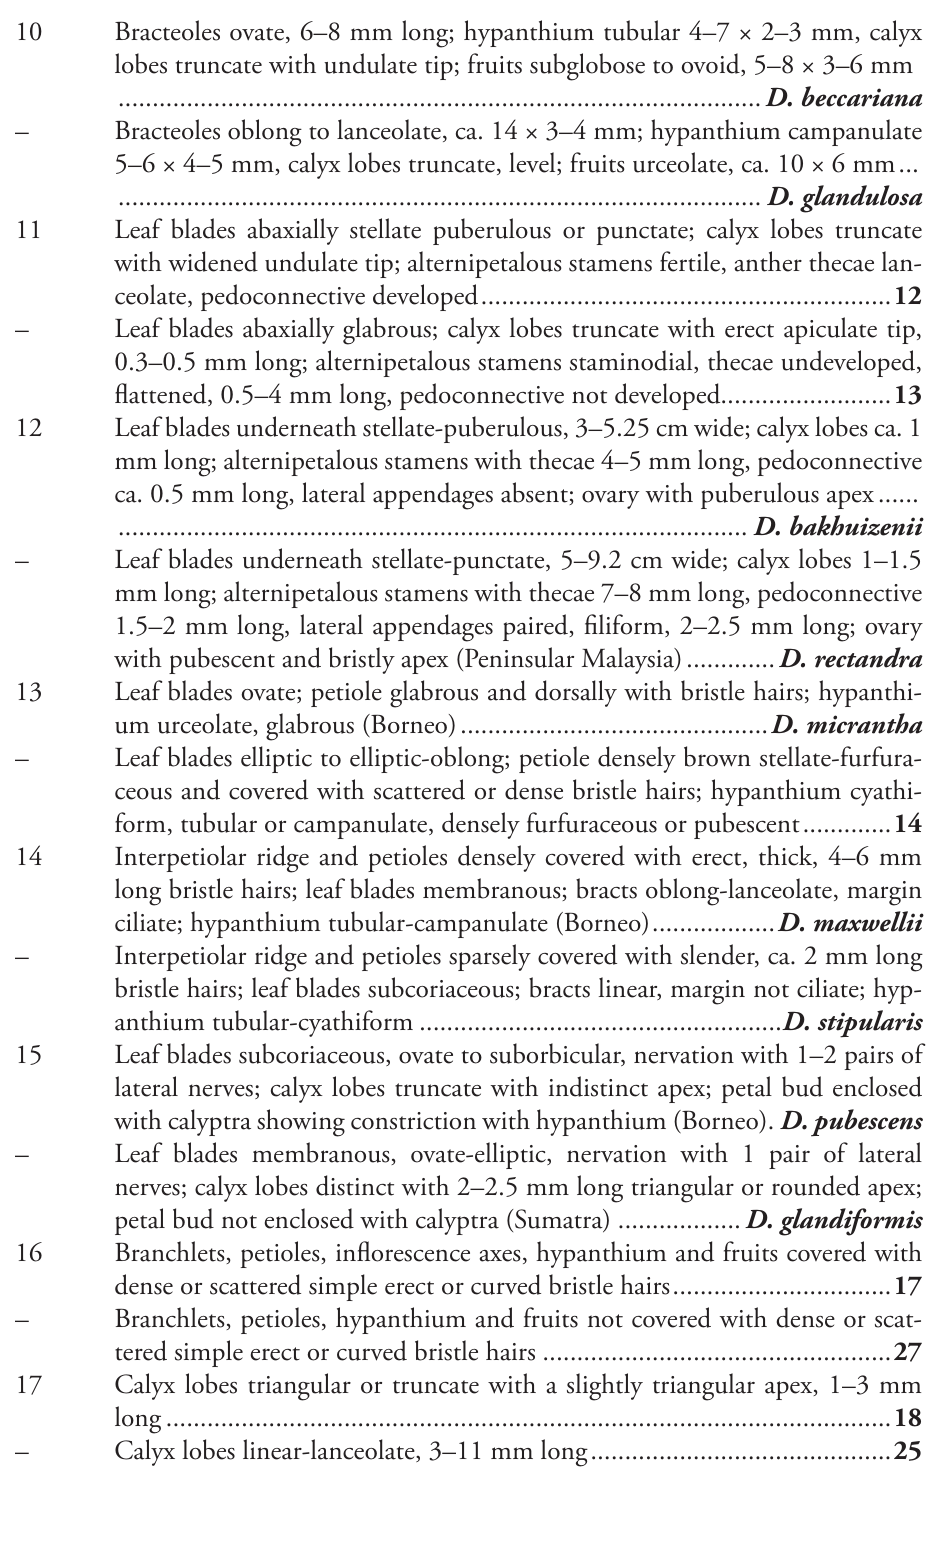
Leaf blades abaxially stellate puberulous or punctate; calyx lobes